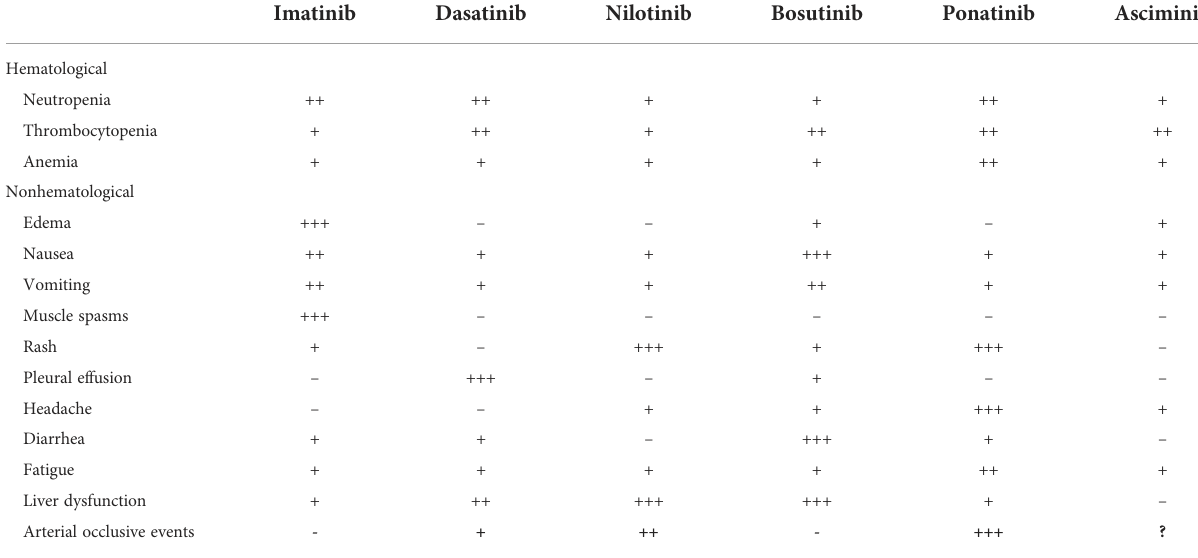
TABLE 1 Adverse event pro fi les of tyrosine kinase